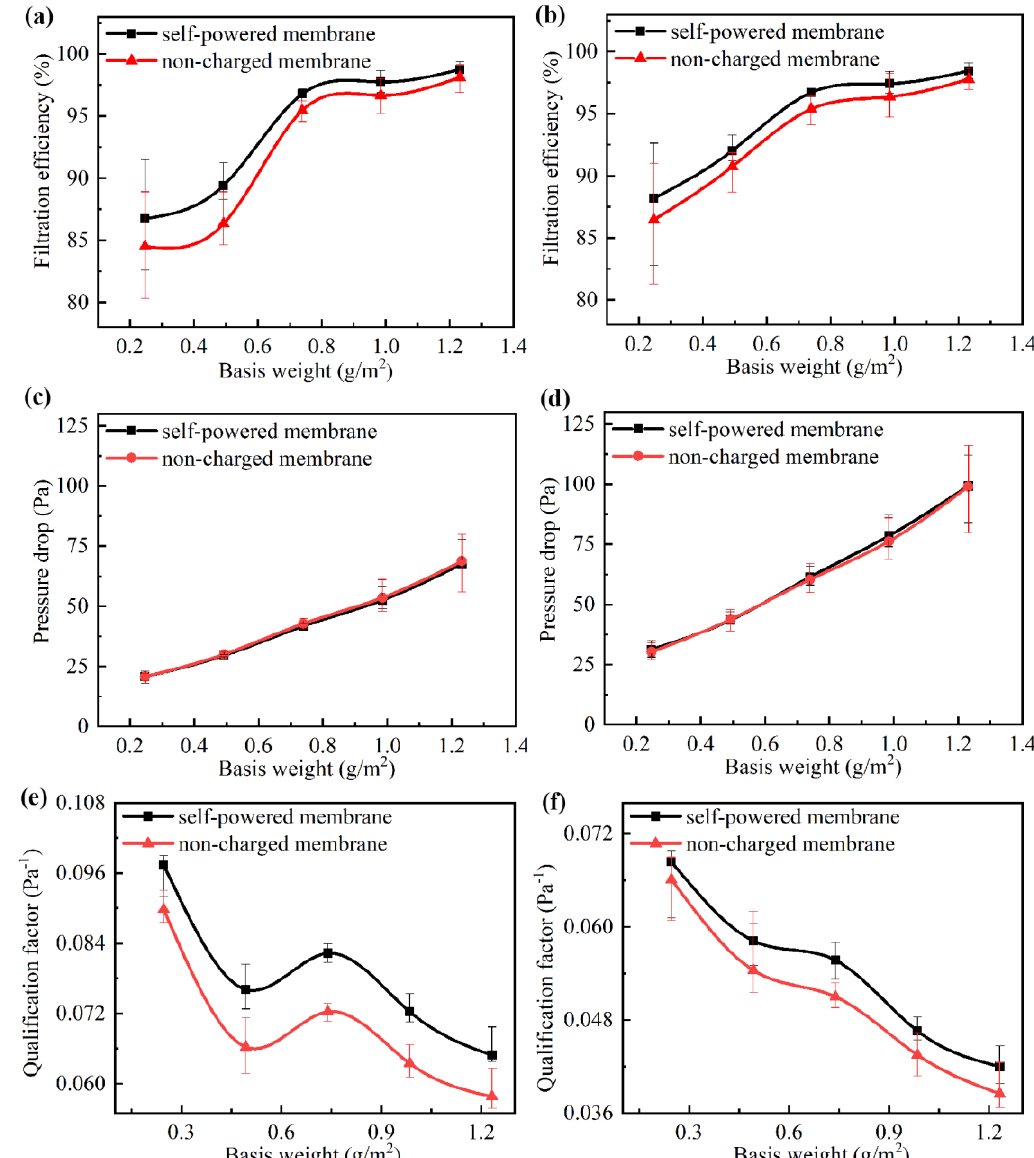
Figure 6. The filtration efficiency ( FE ) of the composite membranes under different airflow velocities: ( a ) 0.1 m/s and ( b ) 0.15 m/s. The pressure drop in the composite membranes under different airflow velocities: ( c ) 0.1 m/s and ( d ) 0.15 m/s. The quality factor ( QF ) of the composite membranes under different airflow velocities: ( e ) 0.1 m/s and ( f ) 0.15 m/s.